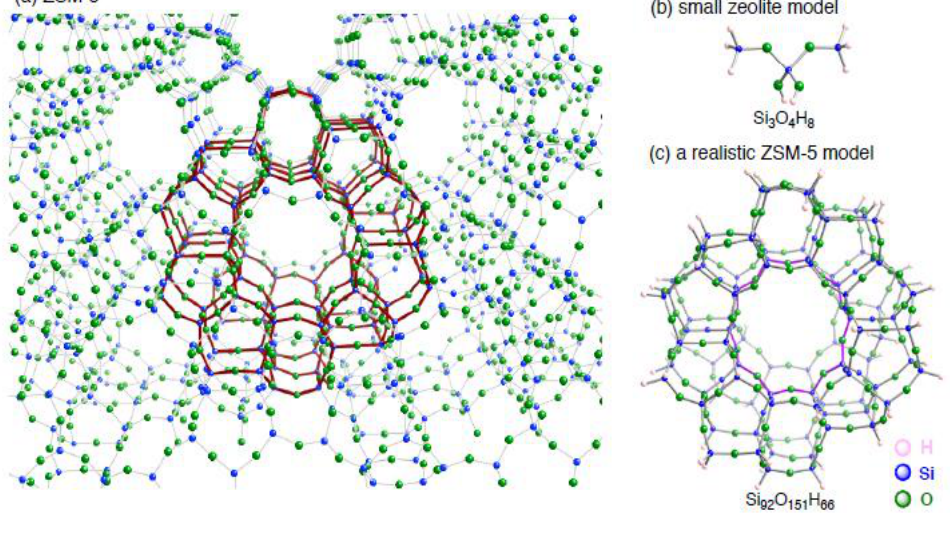
Figure 1. (a) The structures of ZSM-5 zeolite, models of aluminum-free ZSM-5, (b) O H model corresponds to the red part in ZSM-5, Si O H and (c) Si O H . The Si 92 151 66 3 4 8 92 151 66 and terminal atoms are saturated by H